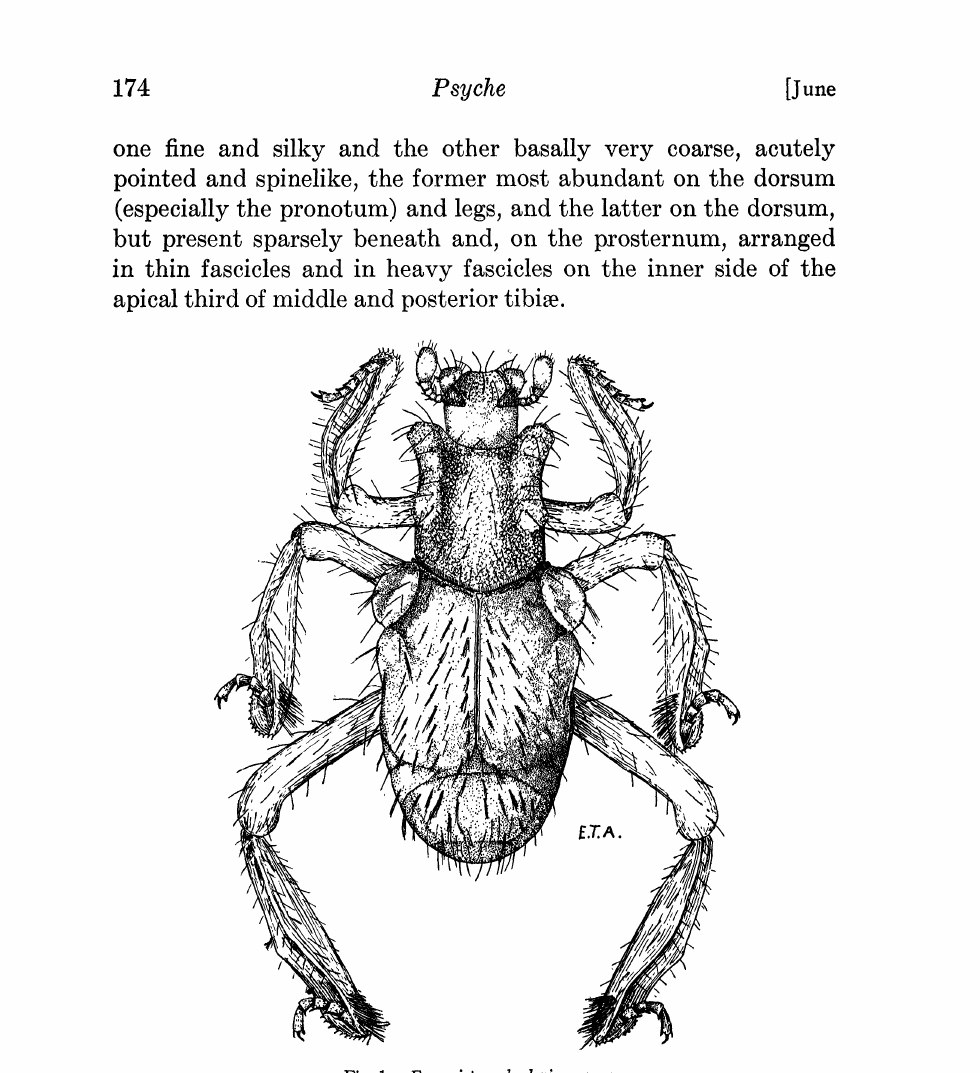
Fig. 1. Euxenister wheeleri sp.